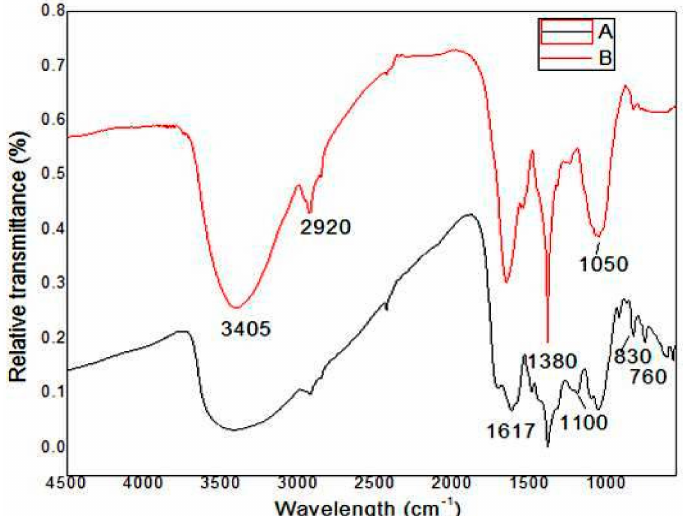
Figure 6. Fourier transform infrared (FTIR) spectra of (A) Eucalyptus globules leaf extract, (B) zinc nanoparticles expressing relative transmittance (%) of functional